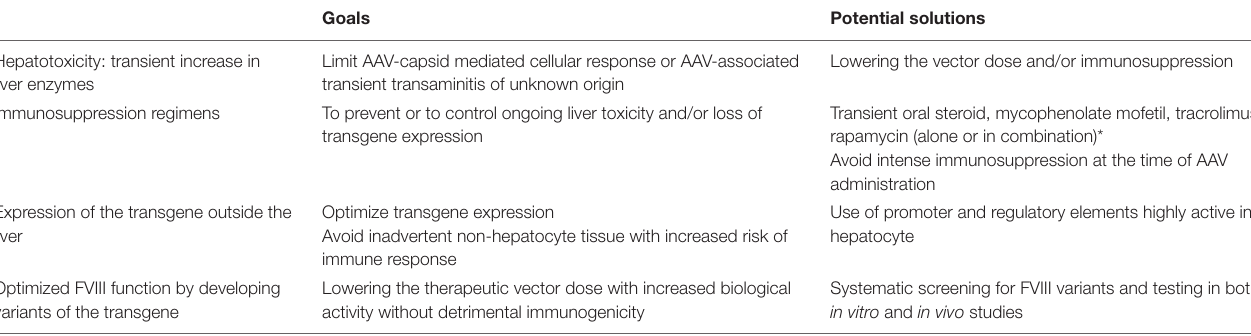
TABLE 3 | Translational considerations of AAV liver gene therapy for immune tolerance induction. Goals Potential